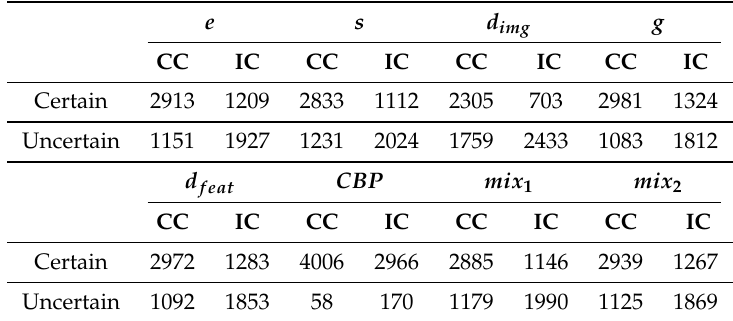
Table 8. Confusion matrices on STL, where CC and IC are the correctly and incorrectly classified samples,